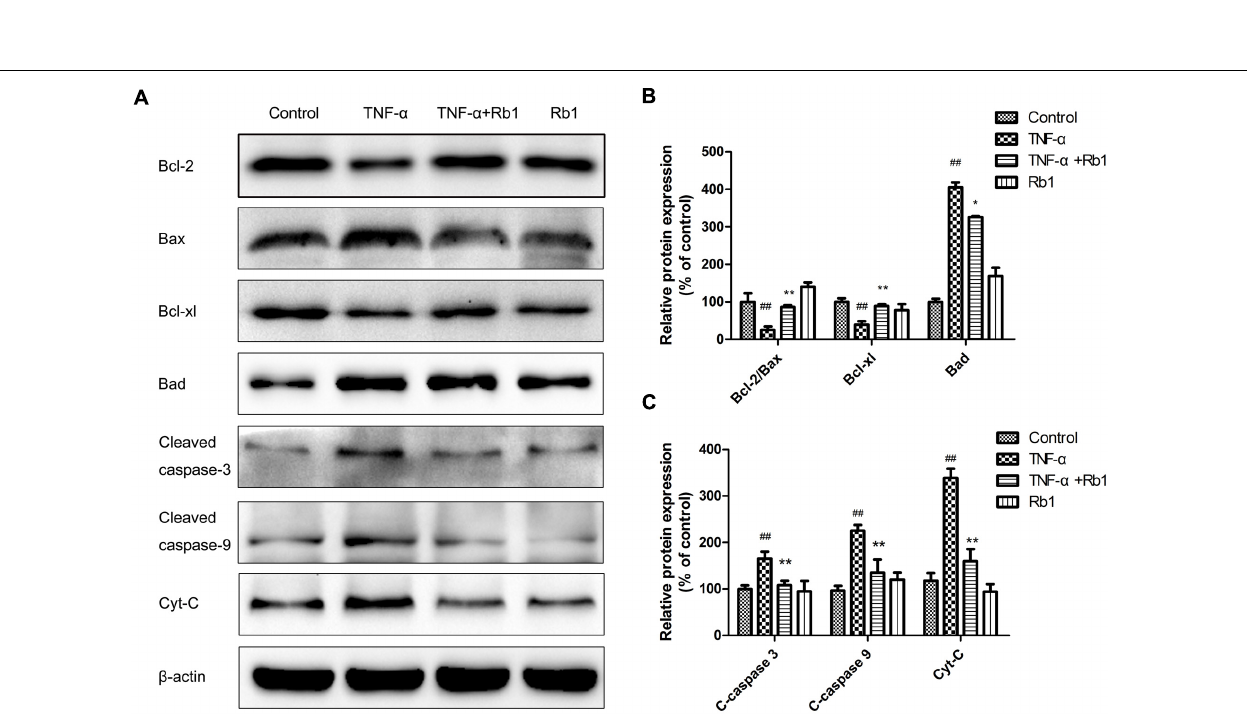
FIGURE 4 | Effects of ginsenoside Rb1 on mitochondrial transmembrane potential. HUVECs were pretreated with Rb1 (20 µ g/mL) for 8 h and then incubated with TNF- α for 24 h. Mitochondrial membrane potential was detected by JC-1 staining, which was visualized by fluorescence microscopy. The images are representative of three experiments.